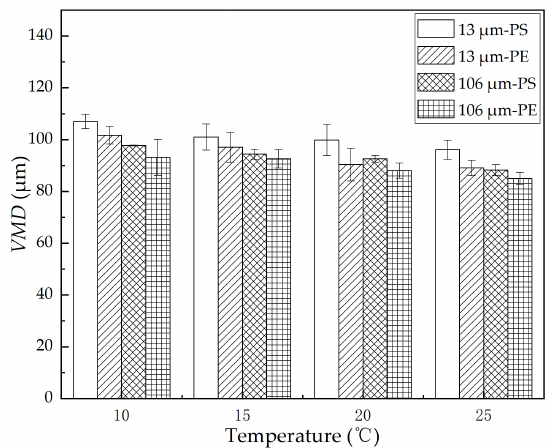
Figure 5. VMD with different MPs at different temperatures. The error bar represents the standard deviation of the measurements of the three parallel samples.